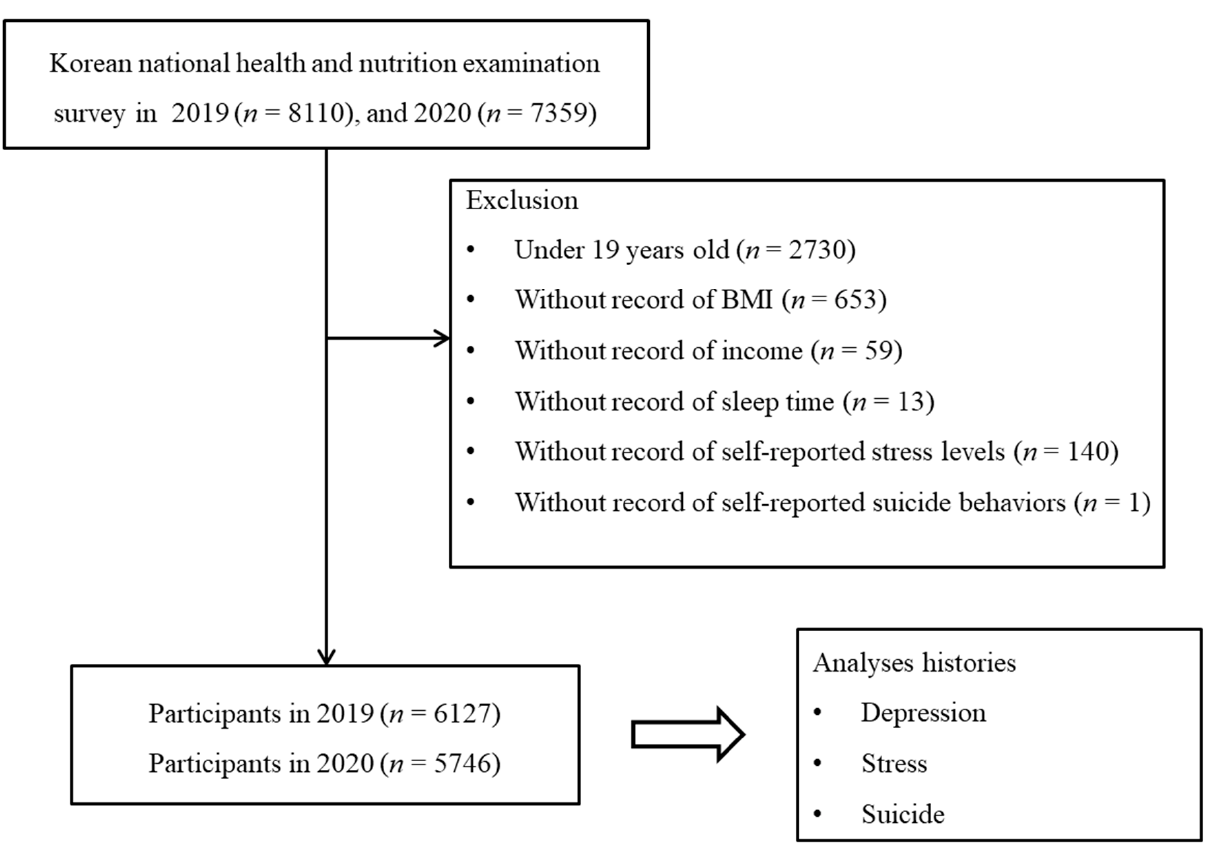
Figure 1. Study design of the present study. A total of 6127 participants from the 2019 cohort population and 5746 from the 2020 cohort population were compared for histories of depression, stress, and suicidal attempts.